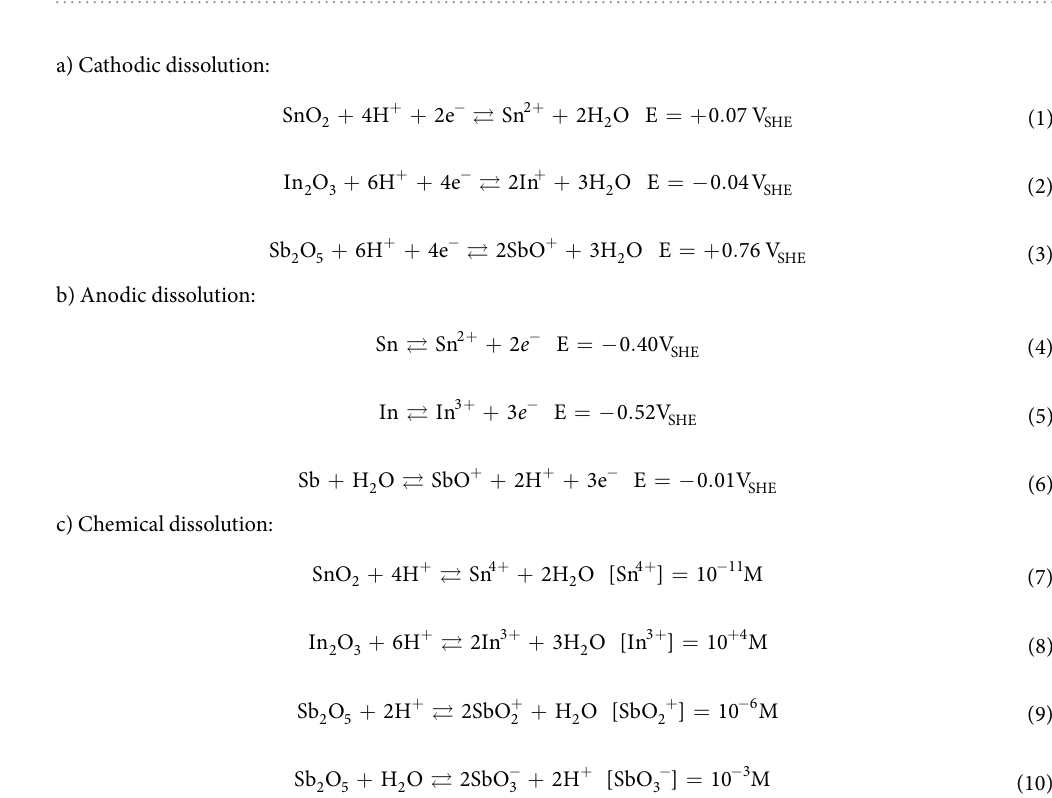
Figure 2. ( a ) Corrosion of FTO and ITO films during a slow scan (5 mV s − 1 ) to 3.2 V RHE in 0.1 M H 2 SO 4 purged with argon. ( b ) Comparison of the integrated dissolution during OER normalized by the portion of the respective element in the material (bars) and onset potential of dissolution, OPD